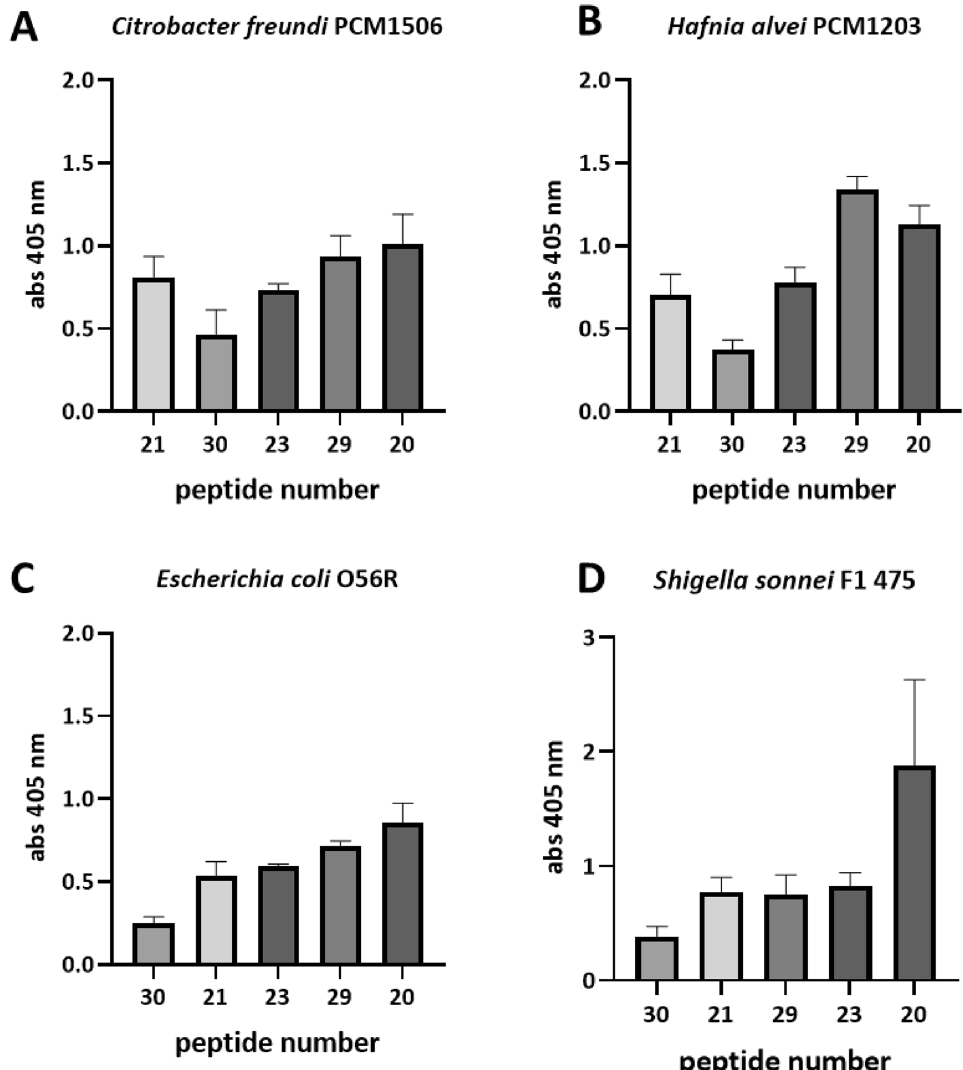
Figure 3. Cross-reactivity analysis of C. difficile FliD peptides with sera from rabbits immunized with other flagellated bacterial strains. C. difficile FliD peptides are organized from the ones with the lowest sequence homology to the flagellar sequences of bacteria used for rabbit immunizations to the ones with the highest sequence homology. Pin-bound ELISA was performed using rabbit sera (1: 1000) from animals immunized with whole acetone-inactivated bacteria. ELISA was performed at least three times. Data shown are means with ±